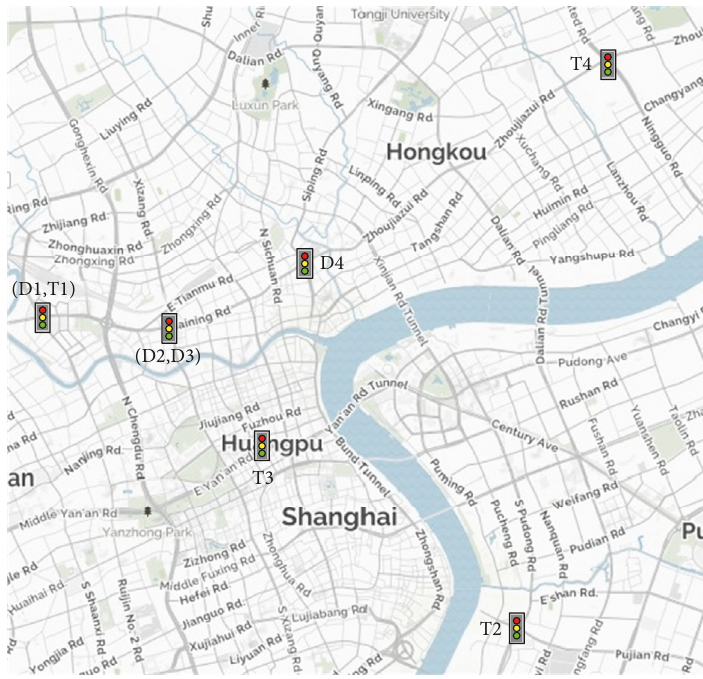
Figure 2: Locations of study